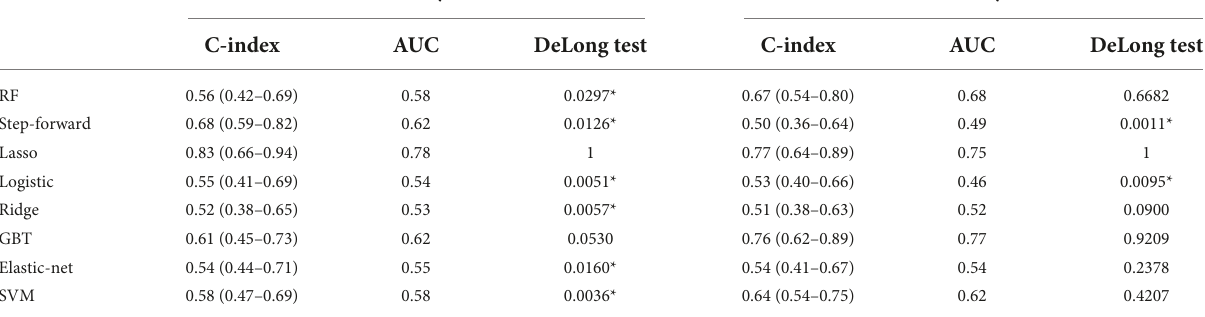
TABLE 2 Discrimination of the models for